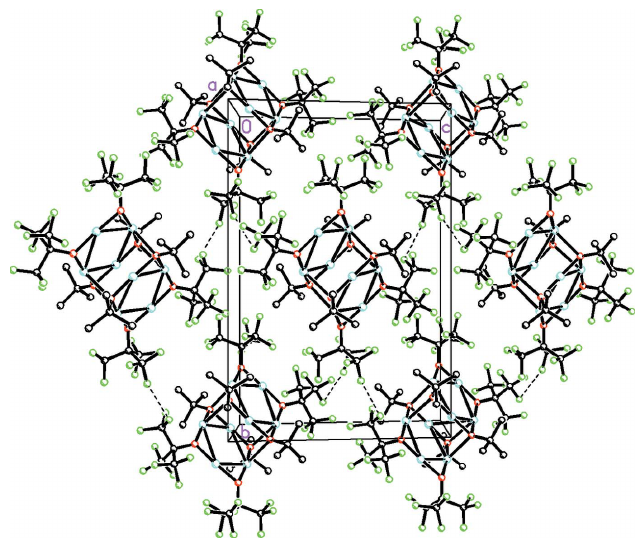
Figure 3 Packing diagram viewed along the a